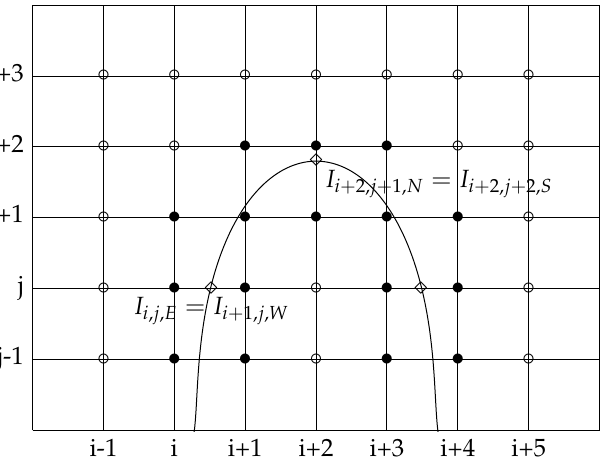
Figure 2. Example of geometrical configuration, with regular grid points (white circles), irregular points (black circles), and interface points (diamonds) with the two possible